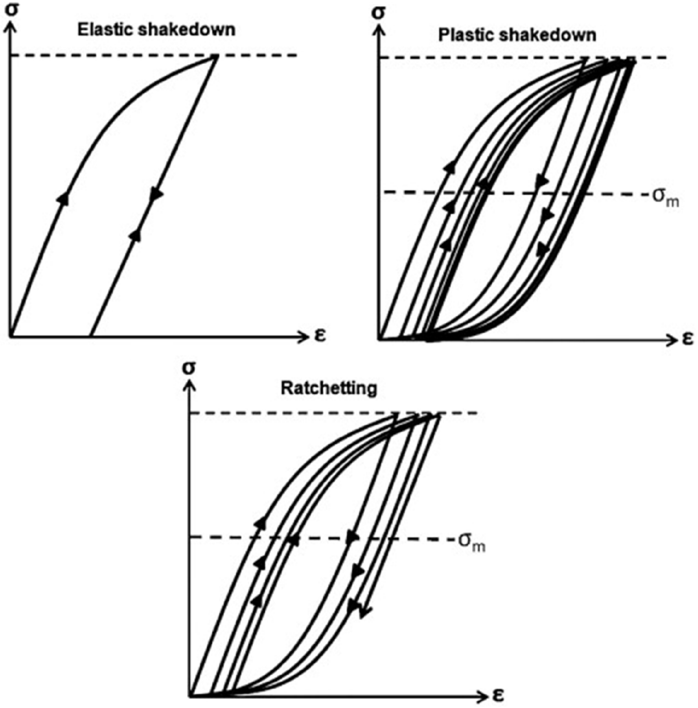
Figure 3. Schematic of the cyclic hardening response of bearing steel subjected to RCF [35].